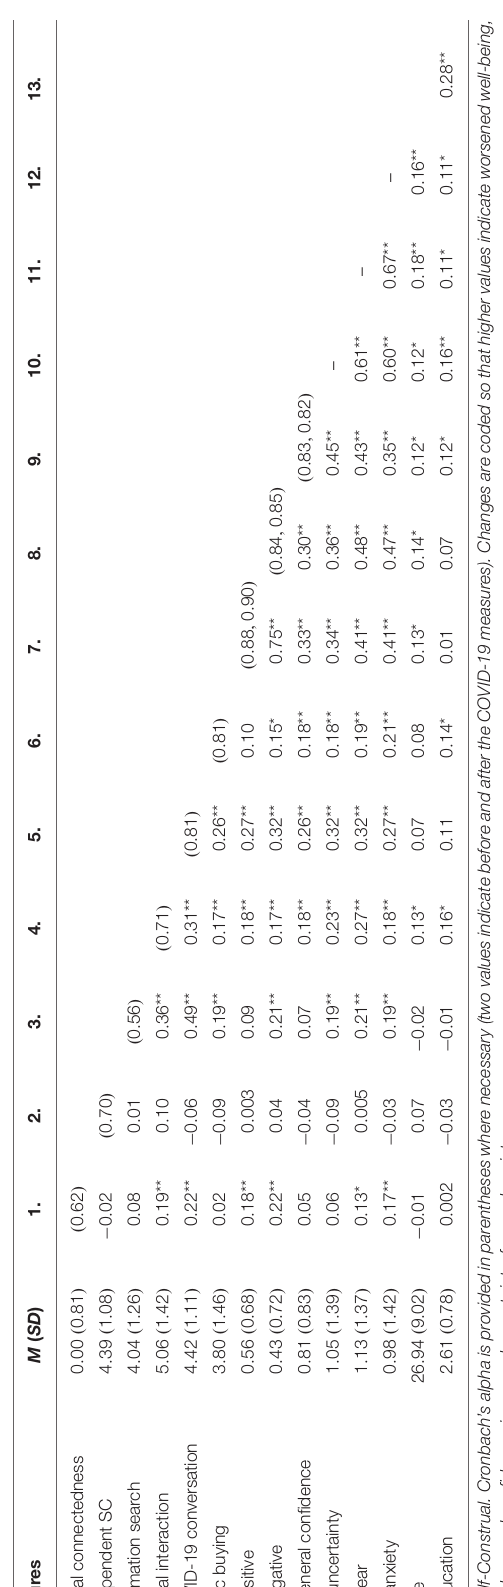
FIGURE 2 | Mediation effect of (cid:49) general confidence level between COVID-19 conversation and panic buying observed in Study 2. ∗∗ p <